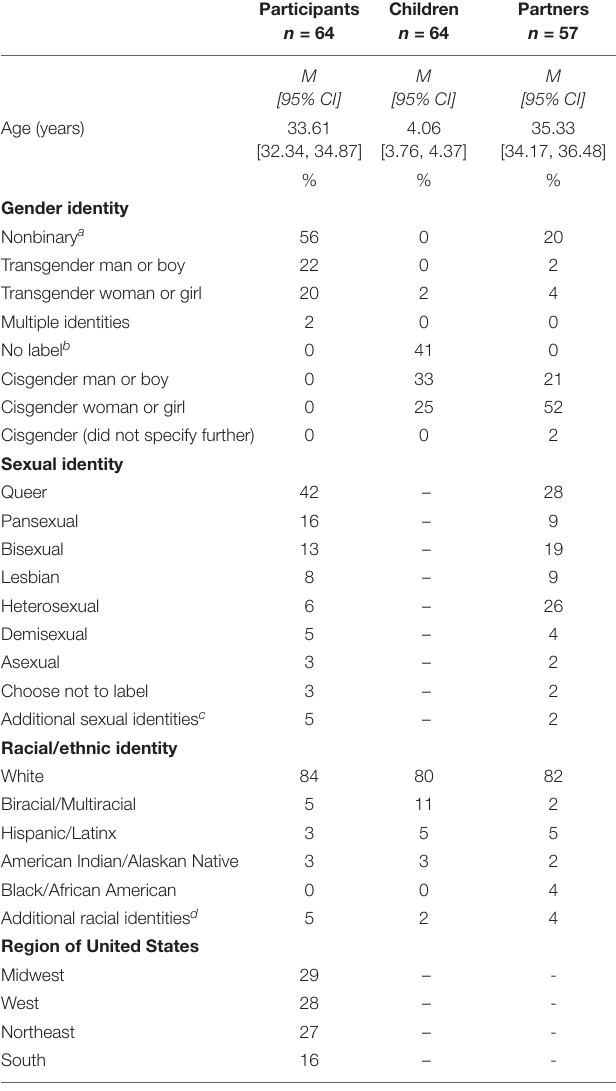
TABLE 1 | Demographic characteristics of nonbinary and binary transgender parent participants, their children, and their